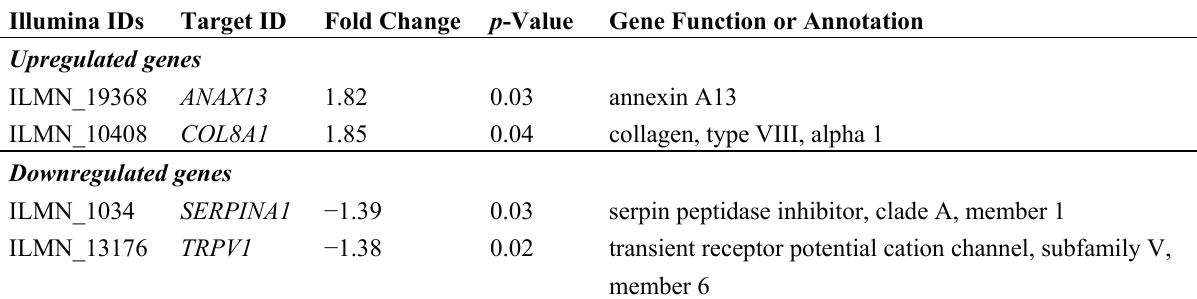
Table 4. List of candidate genes from patients with early loss of renal